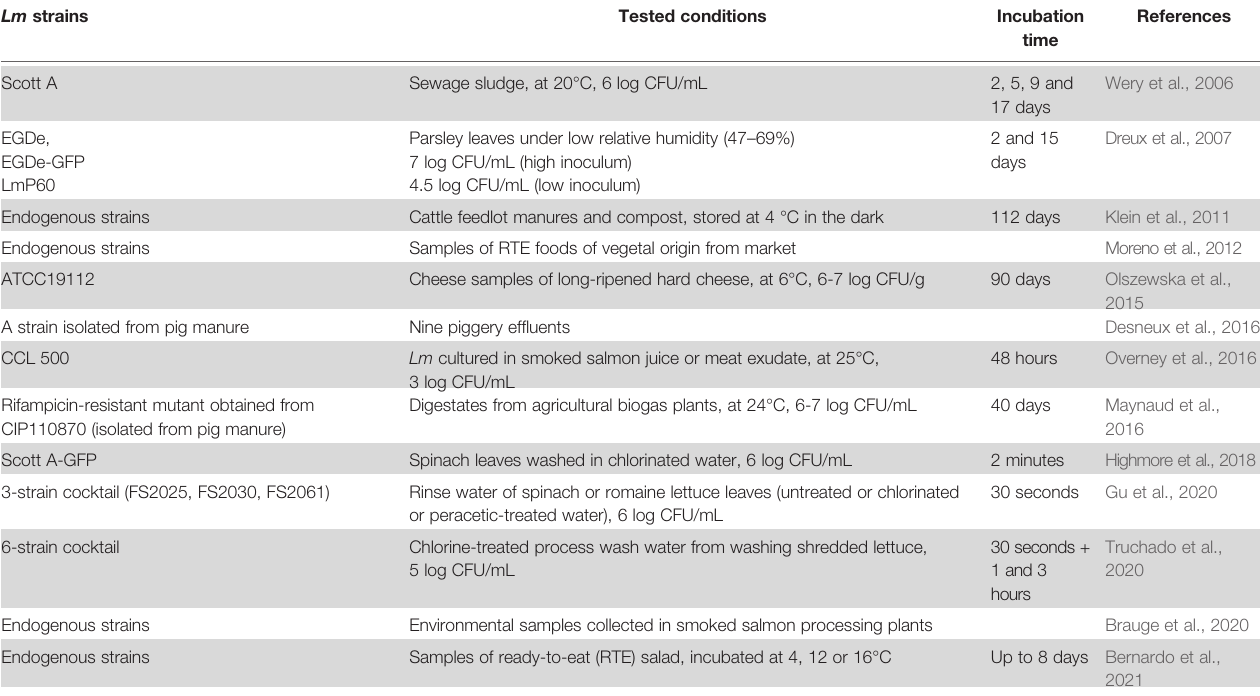
TABLE 4 | VBNC Lm in agri-food industrial